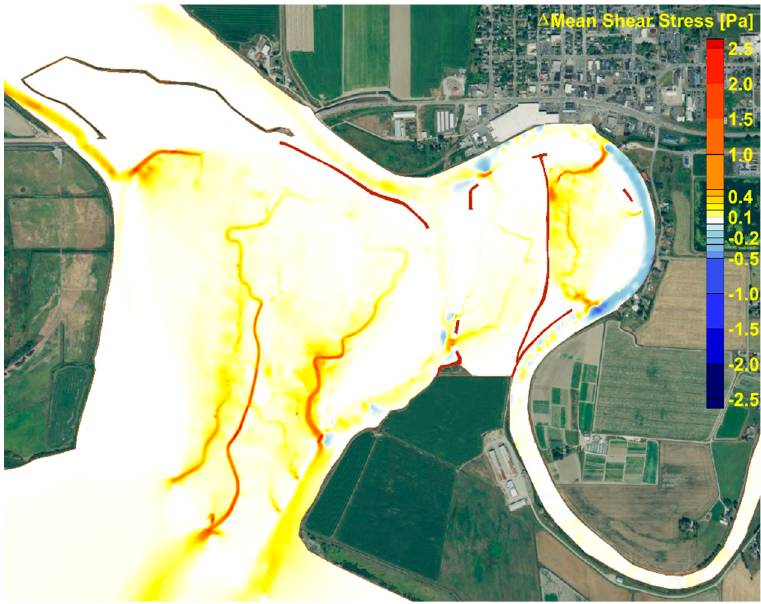
Figure 18. Mean difference bed shear stress contours of the preferred restoration alternative scenario relative to the baseline scenario at the high-flow (bank-full) condition at 750.62 m 3 /s.